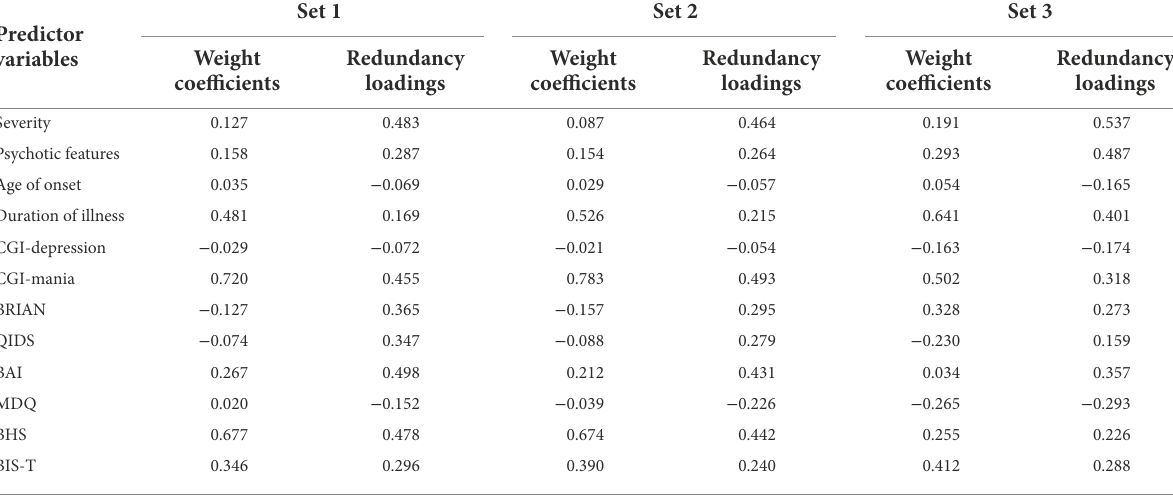
TABLE 5 Weight coefficients and redundancy loadings of the first redundancy variate.